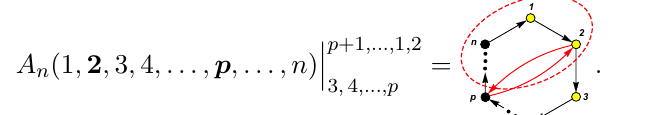
The dashed red line cuts one or two arrows from each of the determinants. The dashed red line cuts one or two arrows from a single the determinant (singular cut). The dashed red line cuts no arrows (singular cut).